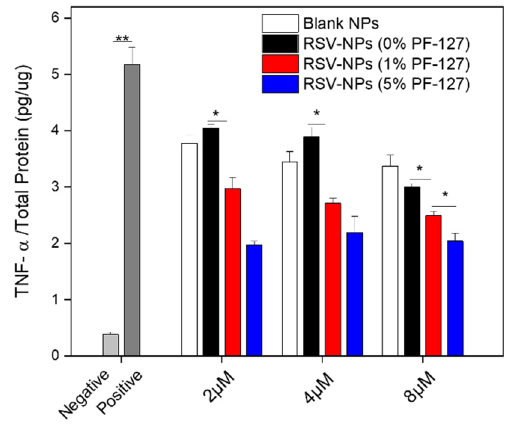
Figure 4. In vitro anti-inflammatory activities of blank NPs, RSV-NPs, PF-127 NPs (1%), and PF-127 NPs (5%) against RAW 264.7 macrophages. The amounts of TNF- α were quantified by using the ELISA method. Each point represents the mean ± S.E.M ( n = 3; * p < 0.05 and ** p < 0.01, Student’s t - test).